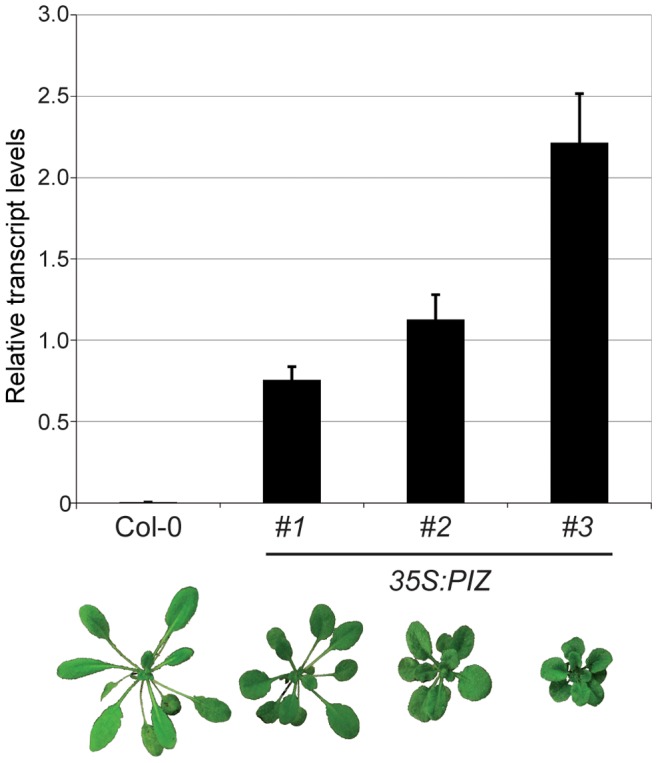
The PIZ transcript levels correlate with the severity of dwarf phenotypes in 35S:PIZ plants.Quantitative PCR analysis of the PIZ transcripts in 21-day-old wild-type (Col-0) and weak, intermediate and strong 35S:PIZ plants (from left to right). Mean expression values from two biological replicates are normalized against those of PP2AA3 and shown with SD.